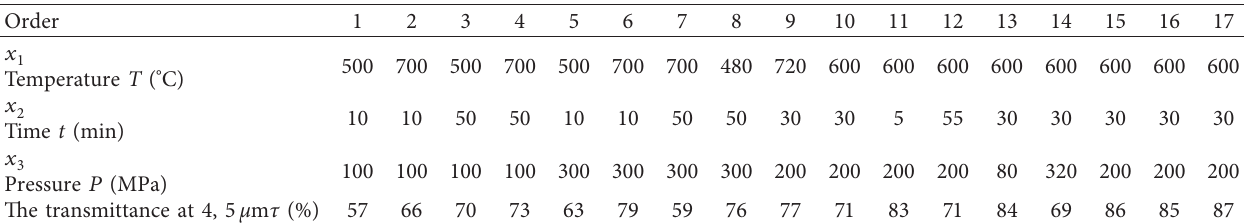
Figure 4: The characteristic transmittance curve. Table 3: The experimental results of the